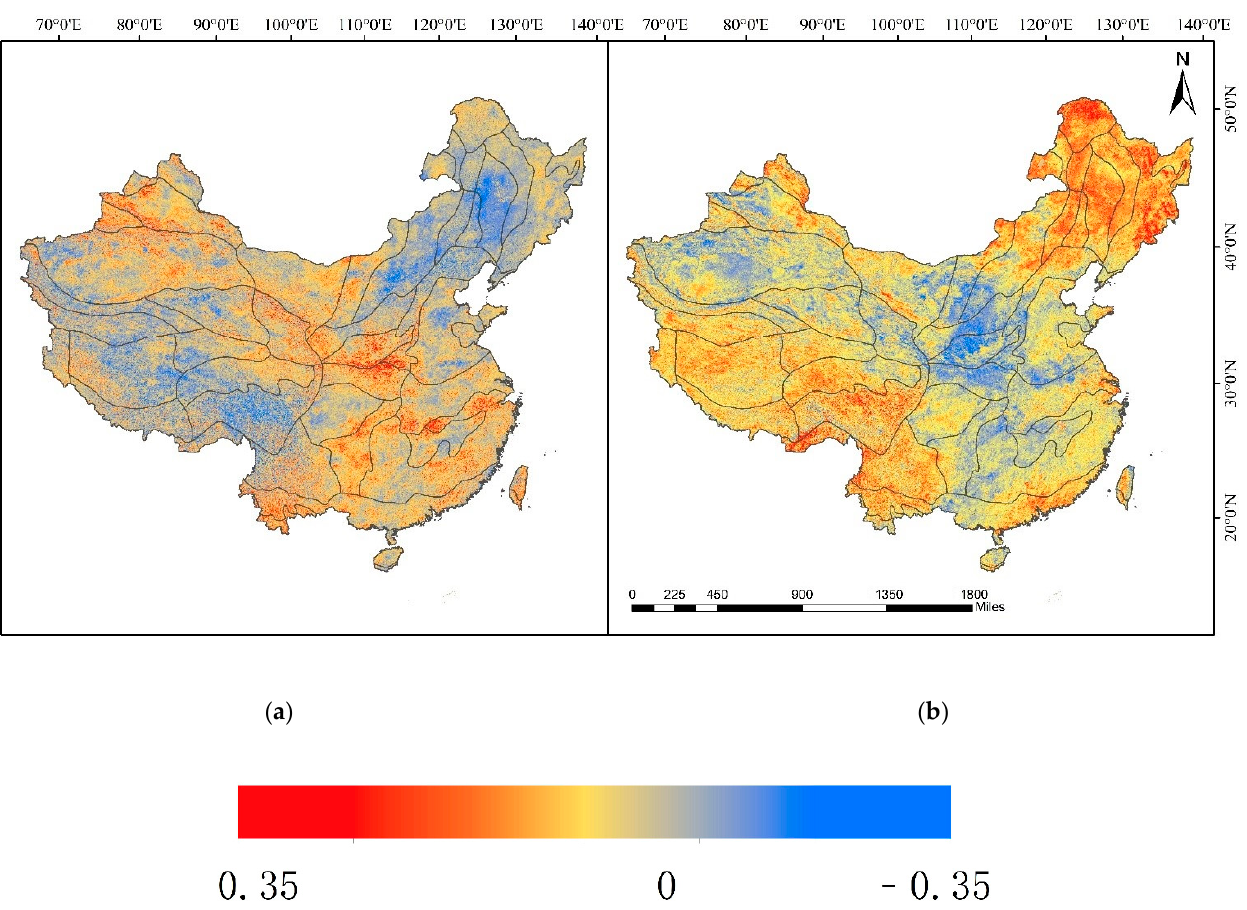
Figure 4. Correlation between remote sensing drought indices and MJO (Except the South China Sea Islands): ( a ) spatial distribution of the correlation coefficient between TCI and RMM; and ( b ) spatial distribution of the correlation coefficient between VCI and RMM.